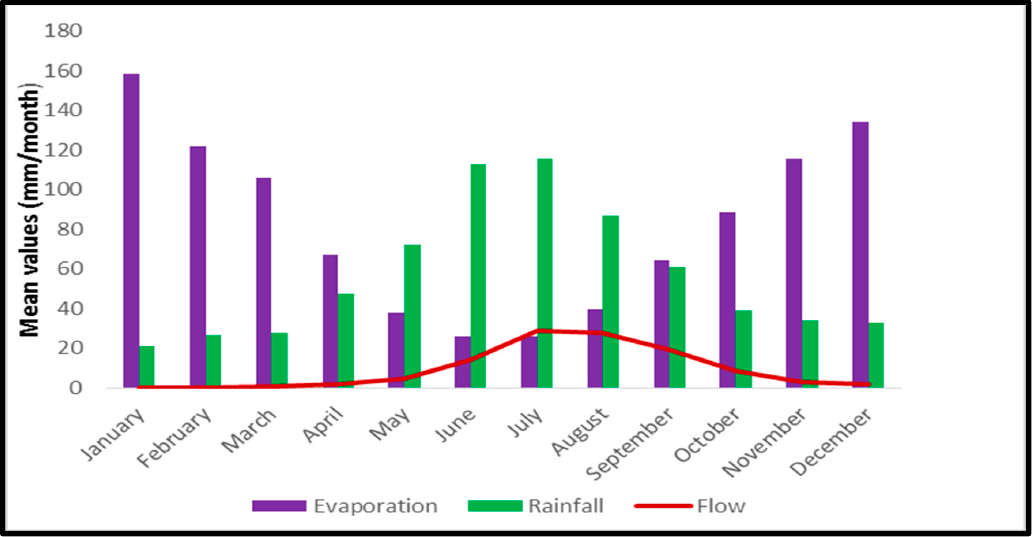
Figure 2. Mean monthly evaporation, rainfall and flow in the Myponga upstream catchment. In PCSWMM, the rainfall runoff process is conceptualized using material and water flow between its environmental sectors. All the processes can be assigned into four compartments: atmospheric compartment; land surface compartment; transport compartment; and ground water